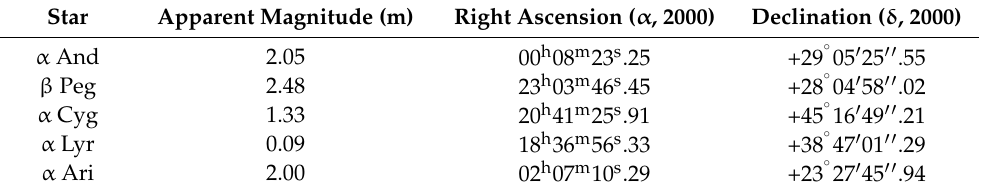
Table 1. A partial list of the observed stars.